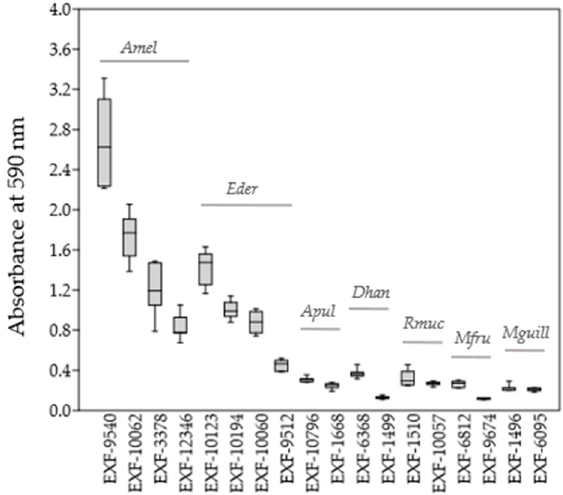
Figure 1. Quantification of biofilm formation by the selected yeast strains using the crystal violet assay.